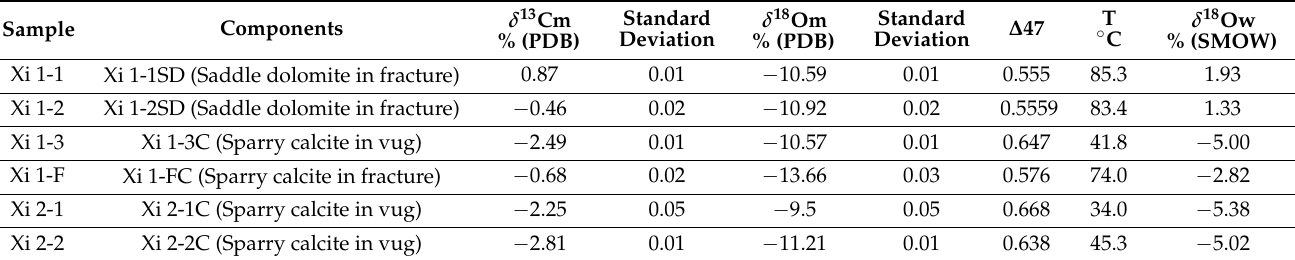
Table 5. The result of U-Pb isotopic